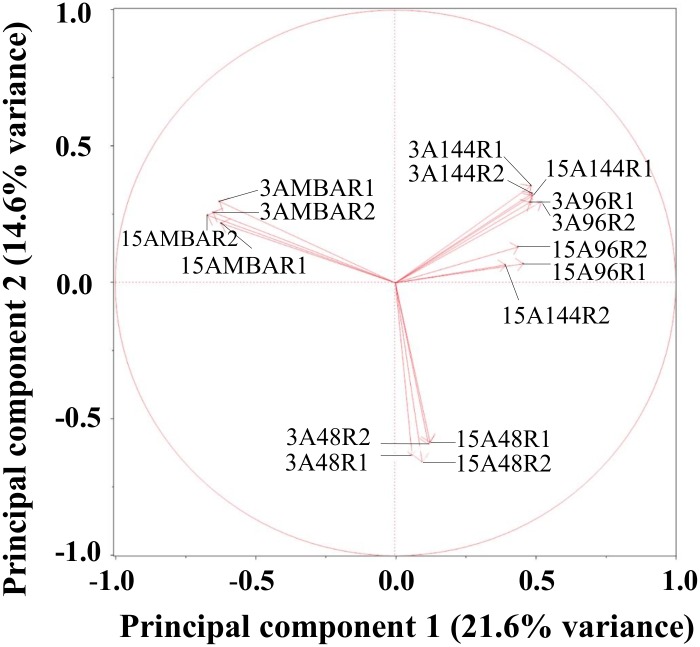
The principal component analysis of transcriptomes from 16 samples.The principal component 1 (PC1) describes 21.6% variance, and differentiate in vitro samples from in planta samples, while principal component 2 (PC2) describes 14.6% variation and differentiate early infection stage (48 HAI) from the late infection stages (96 HAI and 144 HAI). Replications from each condition were clustered together.